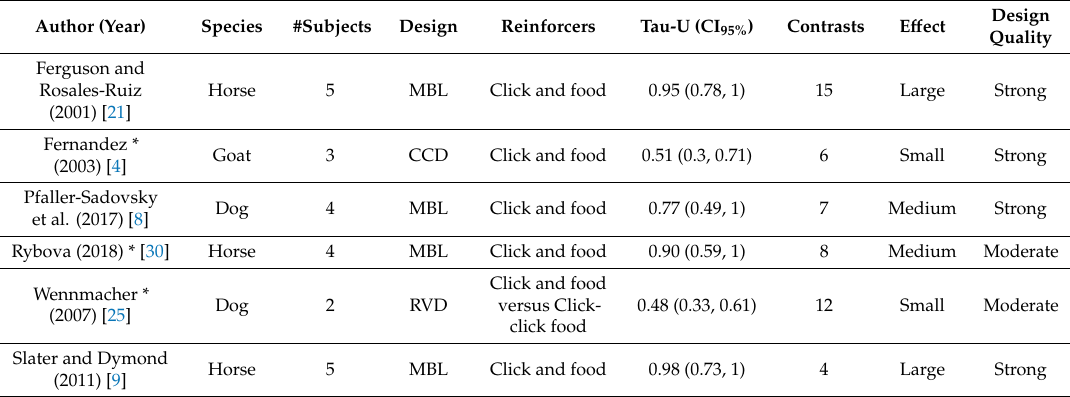
Table 9. Study characteristics and e ff ect sizes per